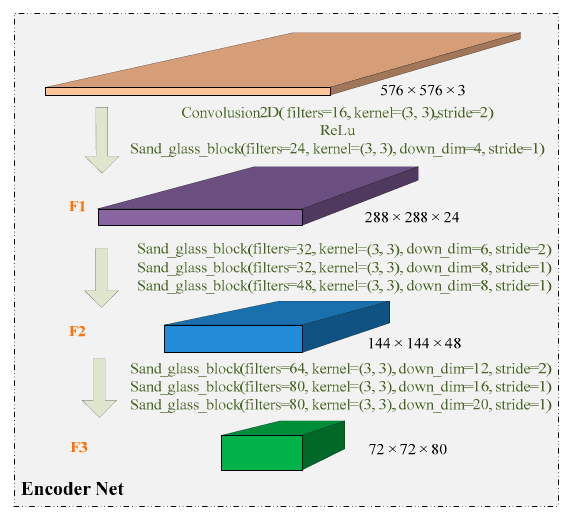
Figure 4. The encoding network structure.